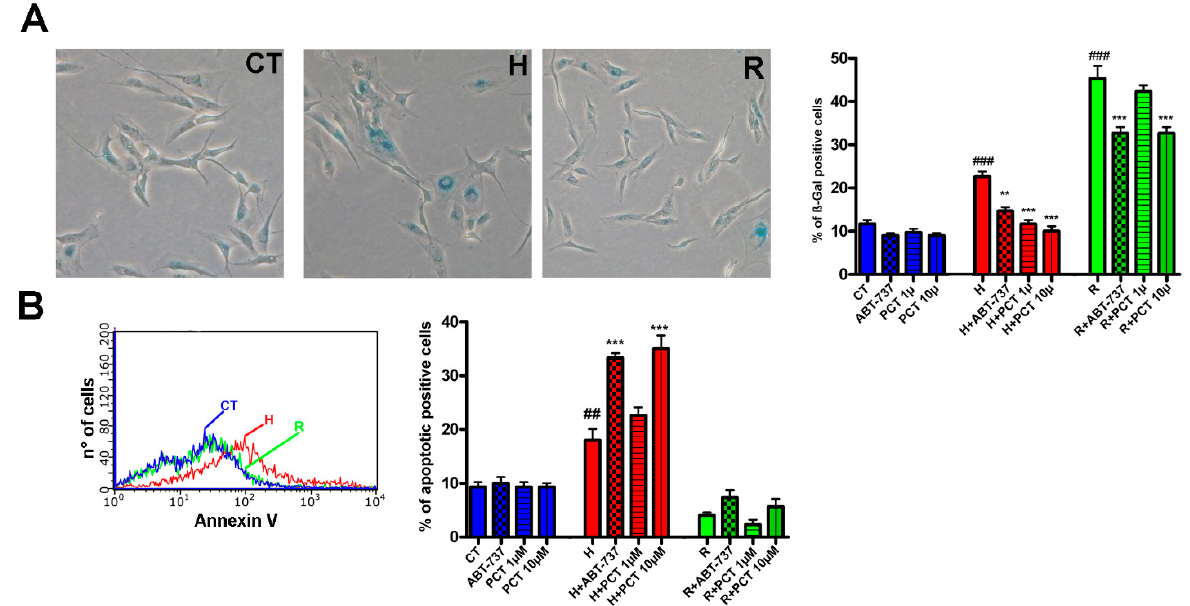
Figure 2. Senolytic versus senotherapeutic effects of piceatannol. Panel ( A ): MSCs at 10 DIV were treated for 30 min with 300 μ M hydrogen peroxide to induce acute senescence, which was evaluated by beta ‐ gal assay 96 h later. Senescence was also determined in 30 DIV cultures. The pictures show representative images of beta ‐ gal staining in control cultures at 10 DIV (CT), in 10 DIV samples treated with hydrogen peroxide (H), and in replicative senescent cultures at 30 DIV (R). The